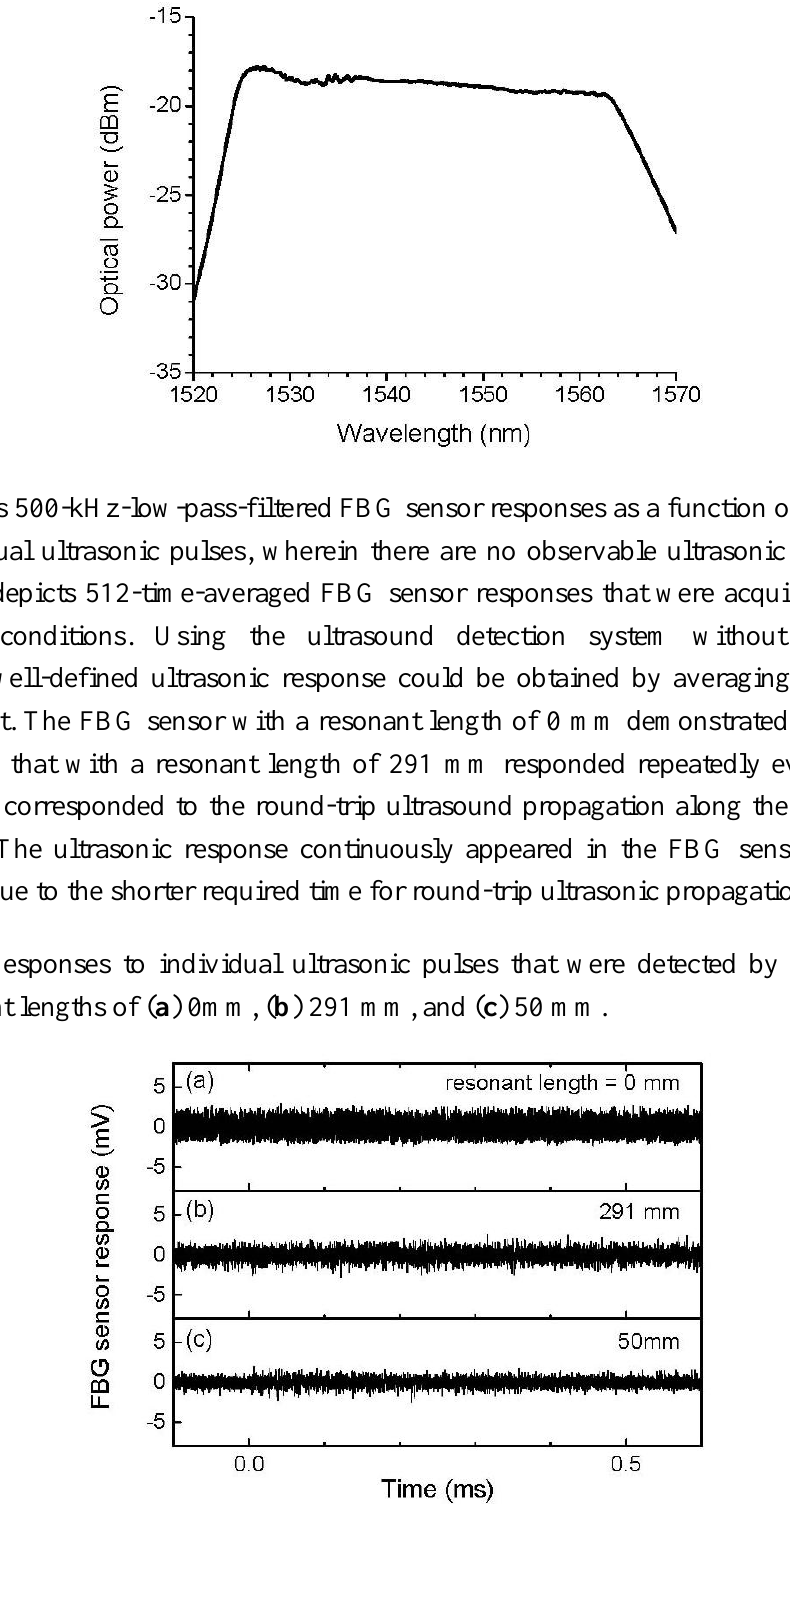
Figure 2. Optical power distribution of the employed broadband light